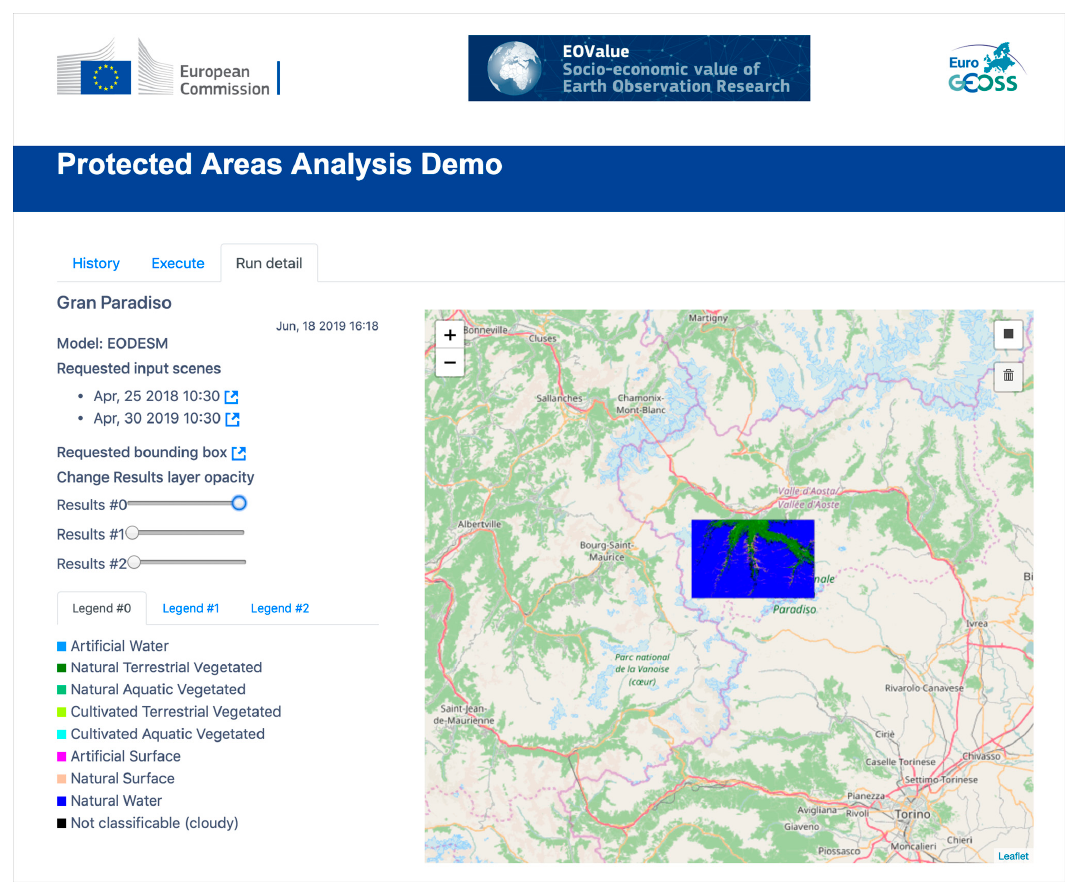
Figure 10. Protected Areas Analysis Web Application (https://pademo.geodab.org/).